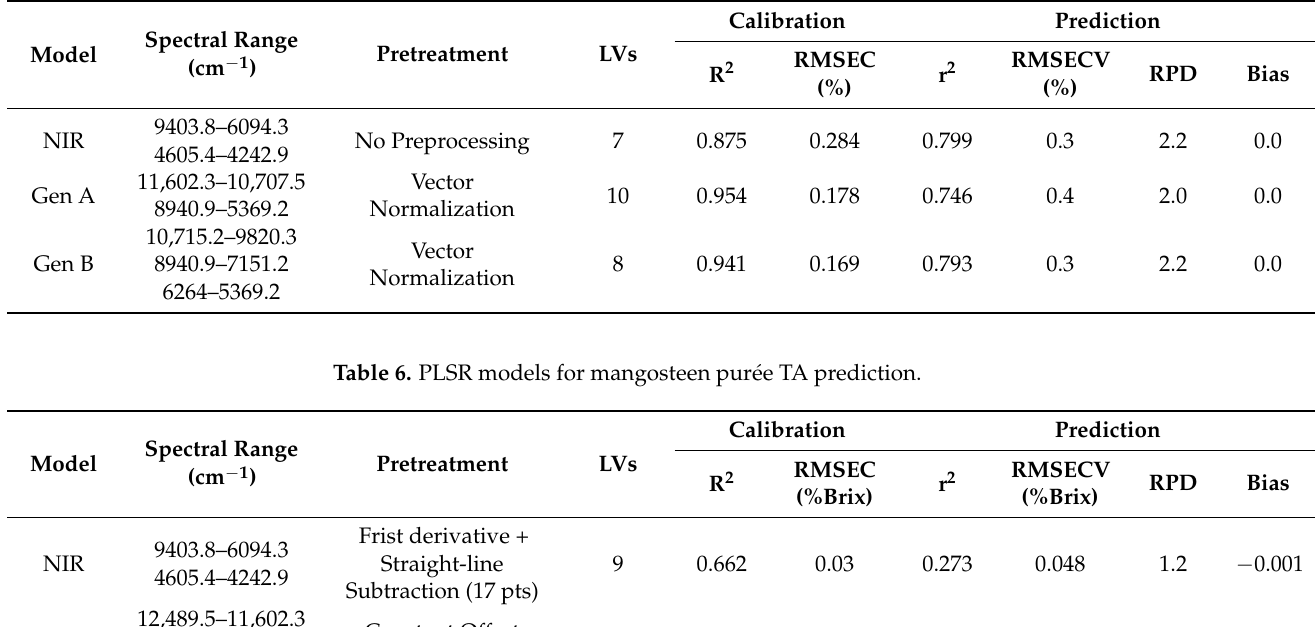
Table 5. PLSR models for mangosteen pur é e TSS prediction.